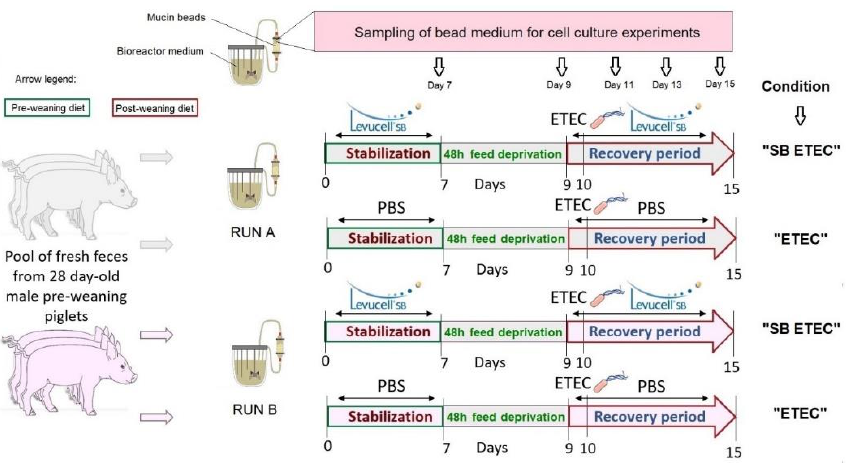
Figure 7. Experimental design of in vitro fermentation procedures and denomination of the